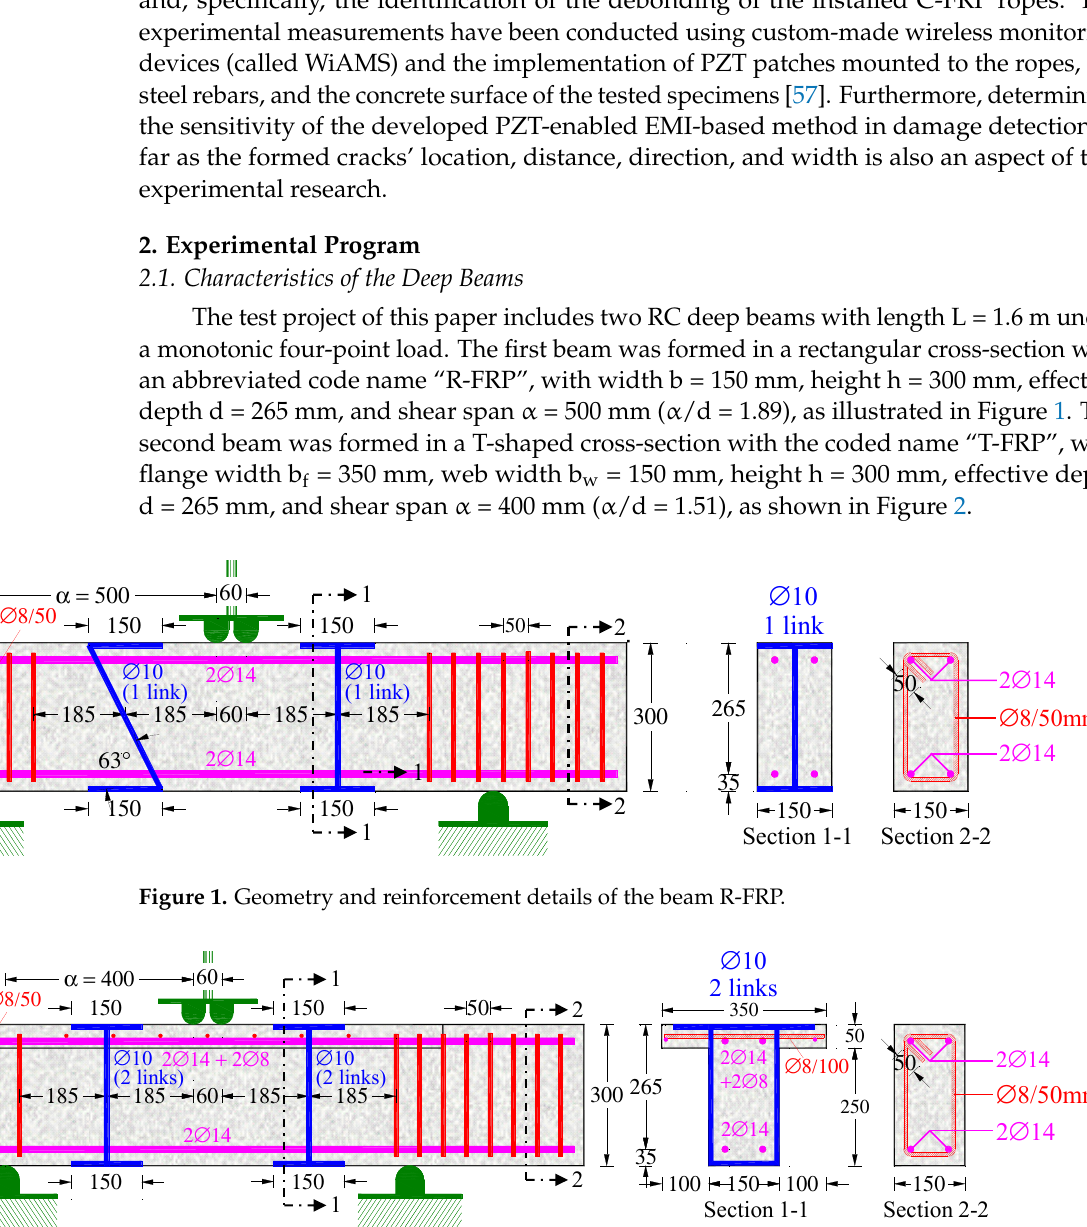
Figure 2. Geometry and reinforcement details of the beam T-FRP.